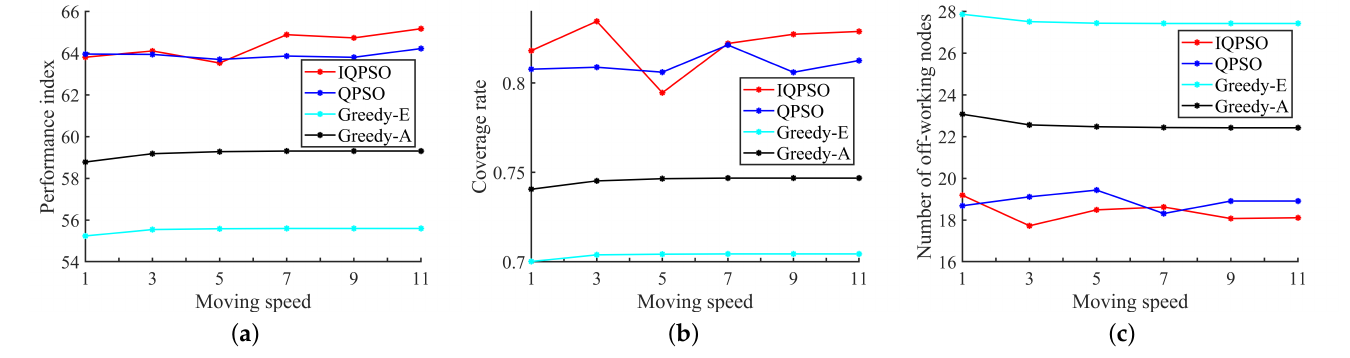
Figure 6. Effect of different MC moving speeds. ( a ) Performance index. ( b ) Coverage rate. ( c ) Number of off-working